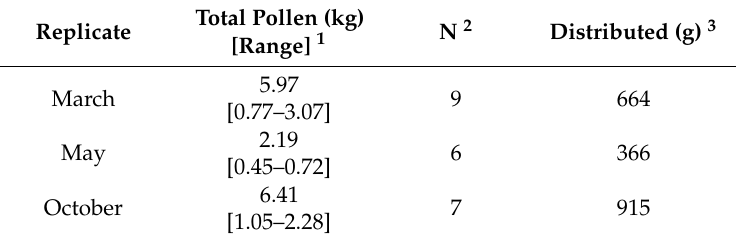
Table 1. Total pollen amounts collected and distributed for each